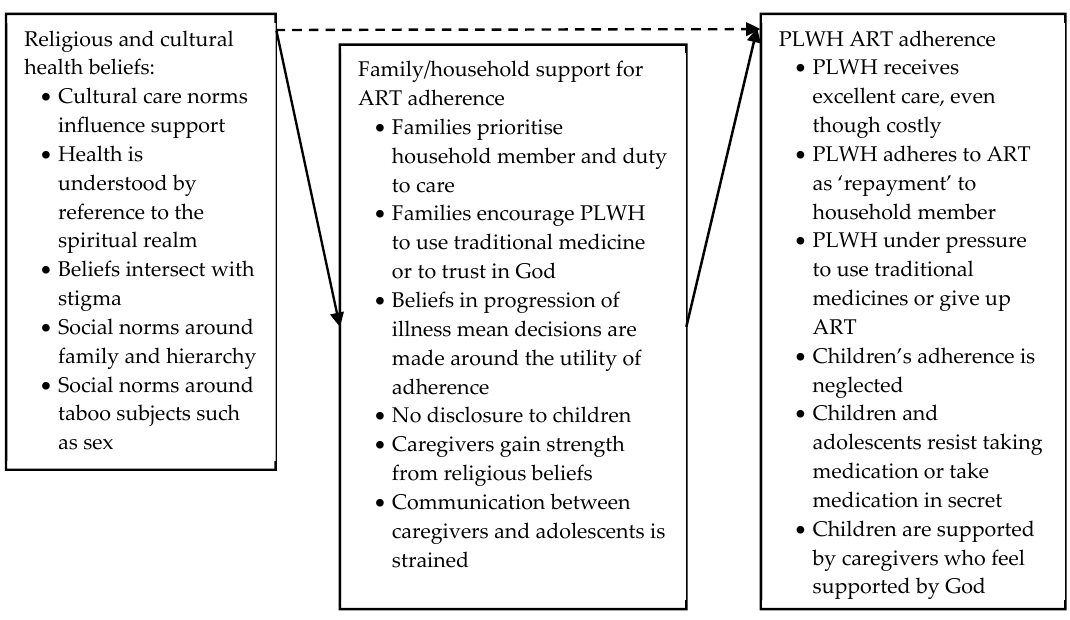
Figure 6. Studies either measured the impact of religious, cultural and health beliefs on the ART adherence of PLWH, or examined the ways in which these beliefs impact ART adherence via household support.